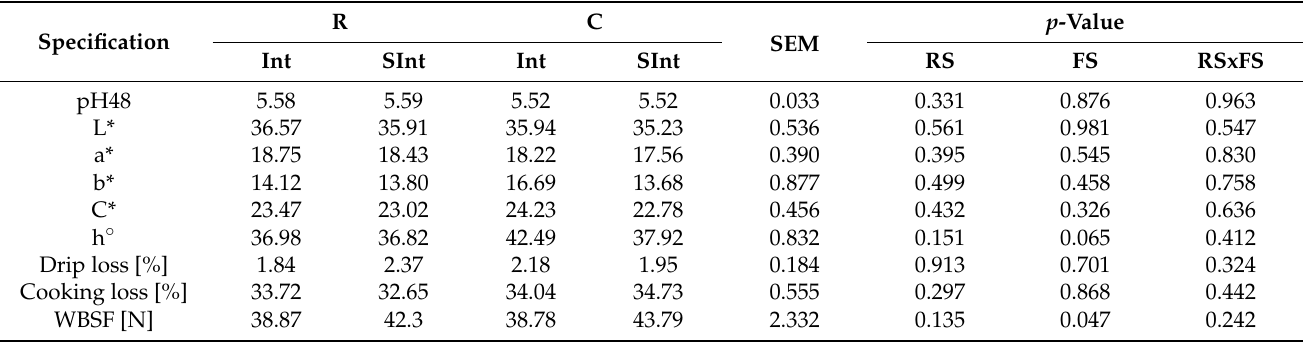
Table 2. Physicochemical properties of the longissimus lumborum muscle.